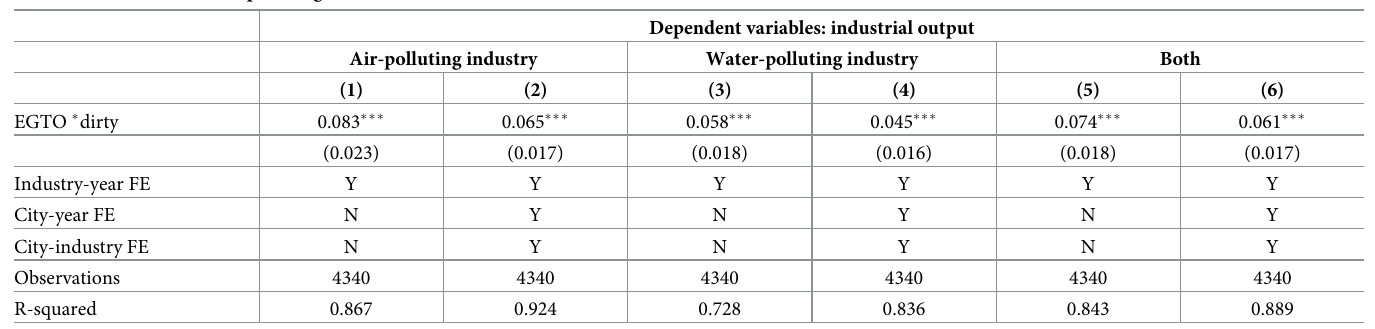
Table 2. Effect of EGTO on polluting activities.